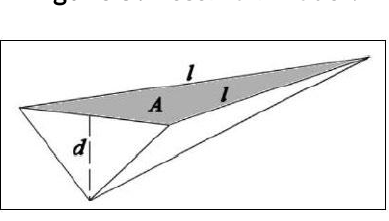
Figure 8. Reservoir